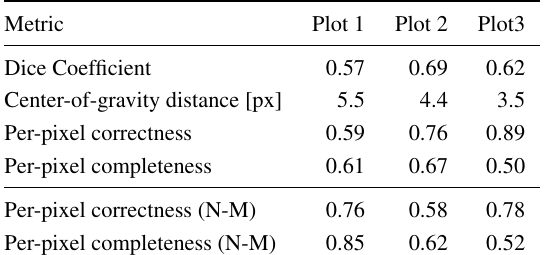
Table 2. Evaluation of detection results. Rows 1-4: average poly- gon matching quality metrics for 1-1 matching. Rows 5-6: aver- age per-pixel correctness and completeness for N-M